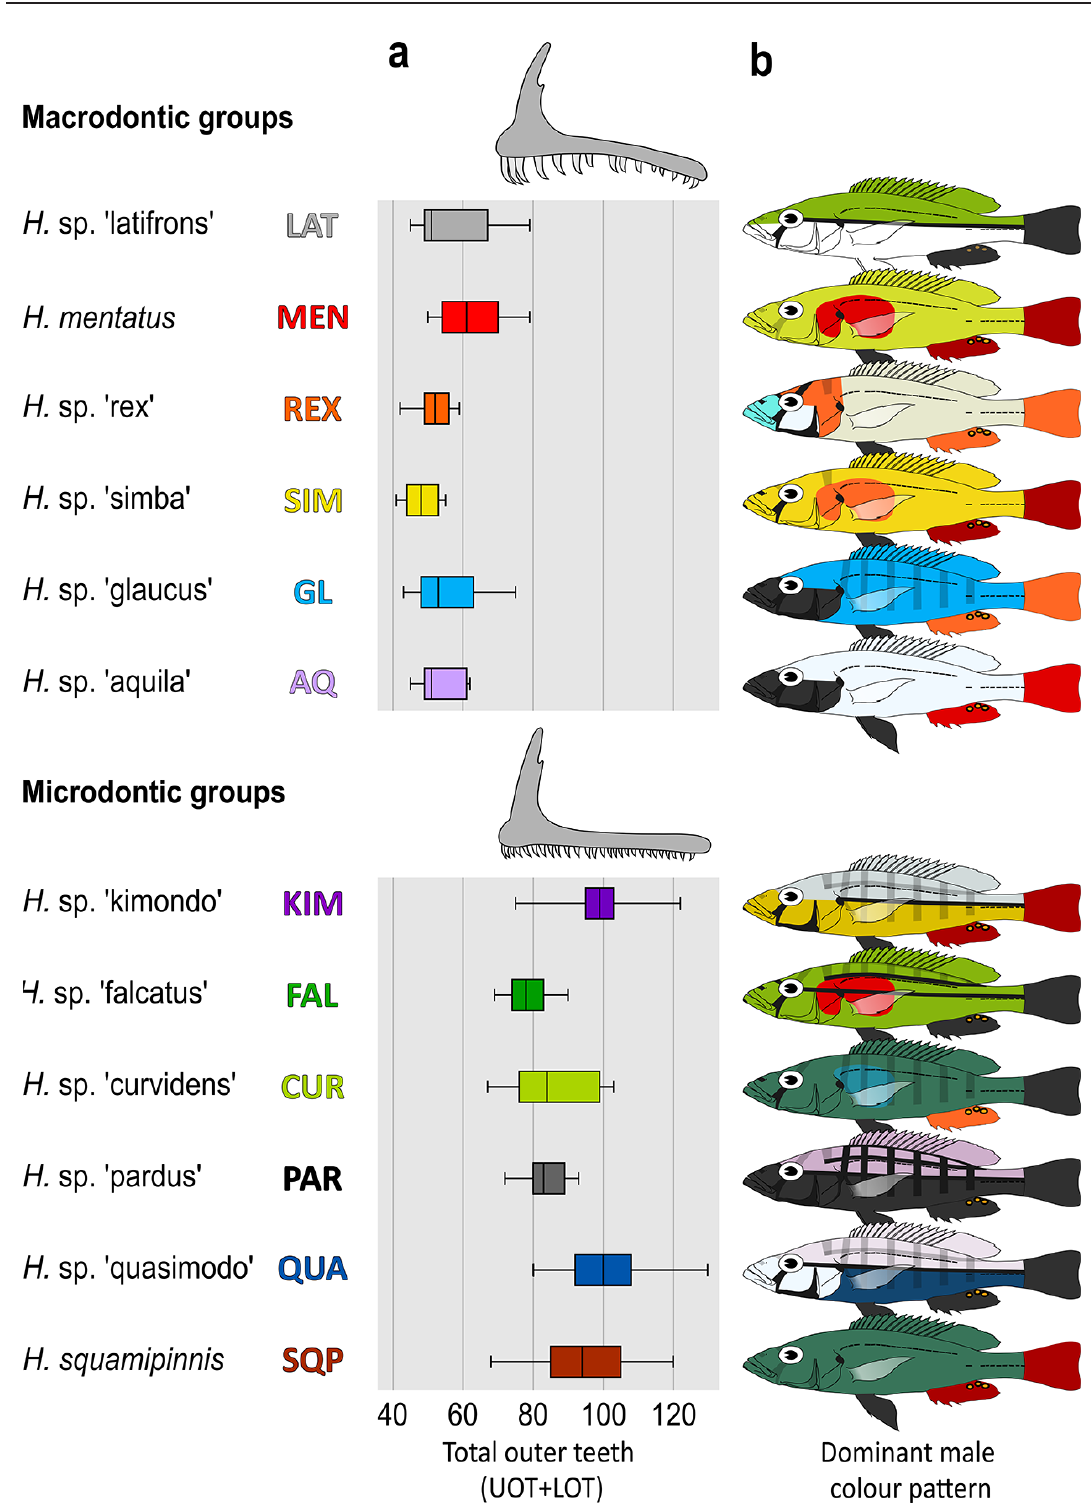
Fig. 2. a . Differences in total number of outer teeth and premaxillary dentition between the macro- and microdontic groups of piscivores from the Lake Edward system. b . Schematic presentation of the dominant male colour patterns in life, in the various groups studied. For H . sp. ‘latifrons’ the female and for H . sp. ‘curvidens’ the non-dominant colour patterns are shown, as those of dominant males are